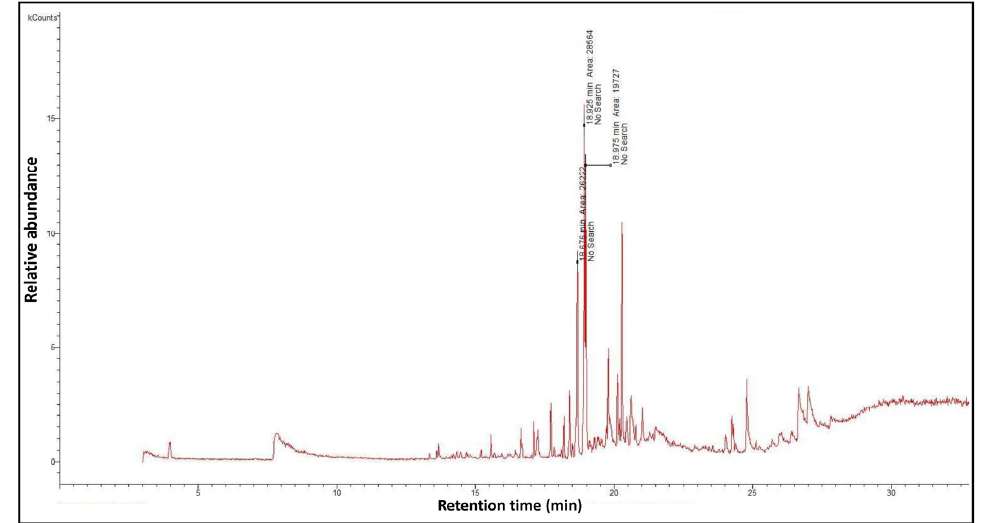
Figure 6. Gas chromatography–mass spectrometry (GC–MS) analysis of T. aphylla ethanolic extract.